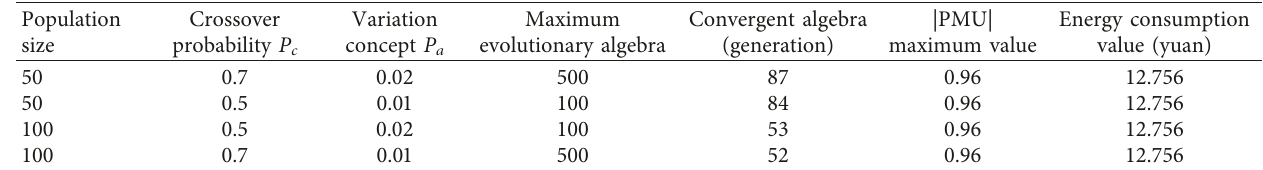
Table 5: Parameter Settings and effects when m � 8 and n � 4.